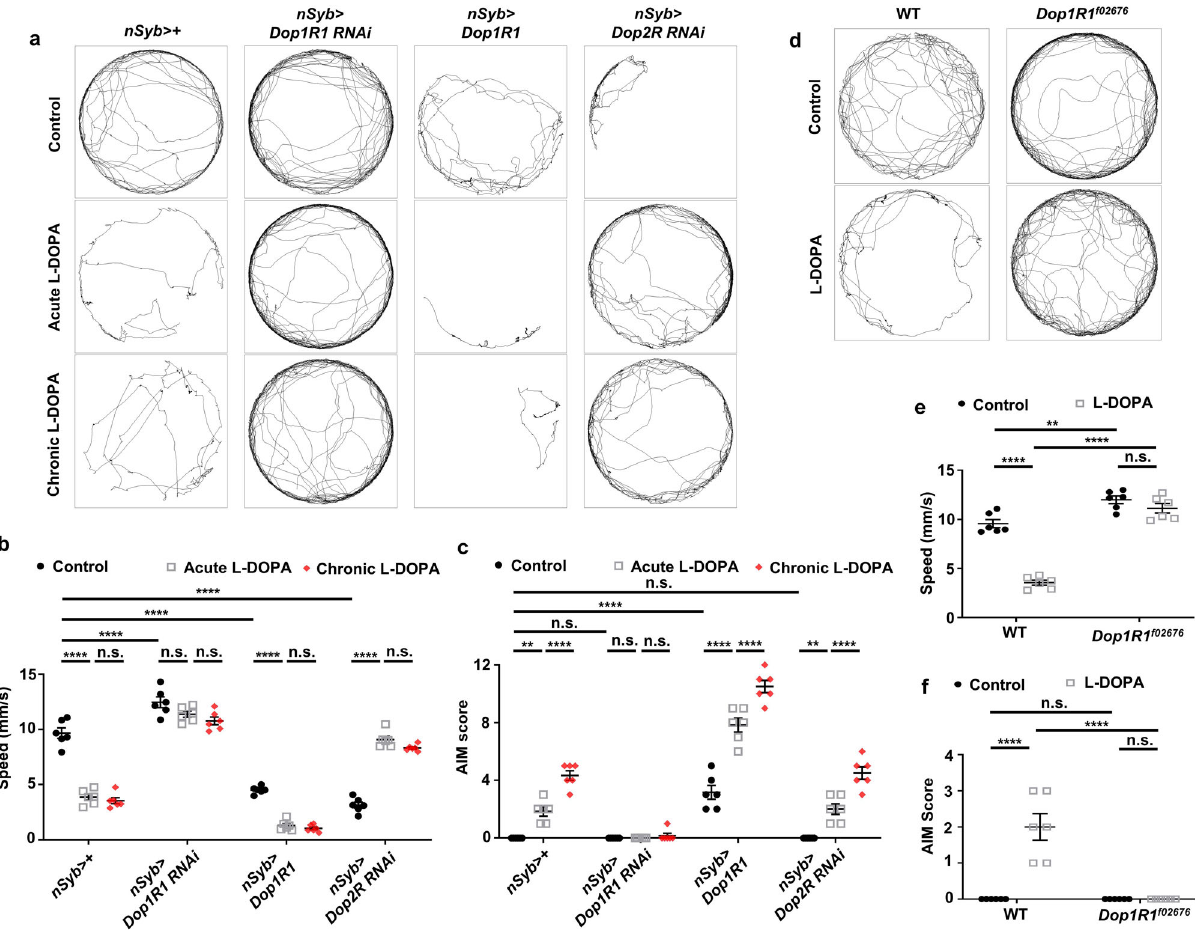
Fig. 4 Dop1R1 is necessary and suf fi cient for LID-like phenotypes. a Representative trajectories of the fl ies with indicated genotypes on a control, acute L- DOPA, and chronic L-DOPA diet. b , c Comparisons of the quanti fi ed speed ( b ), and AIM scores ( c ) of the fl ies with indicated genotypes. N = 6. **** p < 0.0001; ** p < 0.01; n.s., not signi fi cant ( p > 0.05) by two-way ANOVA Tukey ’ s multiple comparison test and are presented as means ± SEM. p < 0.05 was considered statistically signi fi cant. d Representative trajectories of the fl ies with indicated genotypes. e , f Comparisons of the quanti fi ed speed ( e ) and AIM scores ( f ) of the fl ies with indicated genotypes. N = 6. **** p < 0.0001; ** p < 0.01; n.s., not signi fi cant ( p > 0.05) by two-way ANOVA Tukey ’ s multiple comparison test. Data are presented as means ± SEM. p < 0.05 was considered statistically signi fi